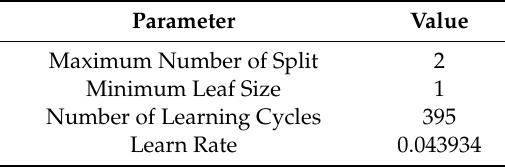
Table 5. Tuned parameter for LSBoost system.